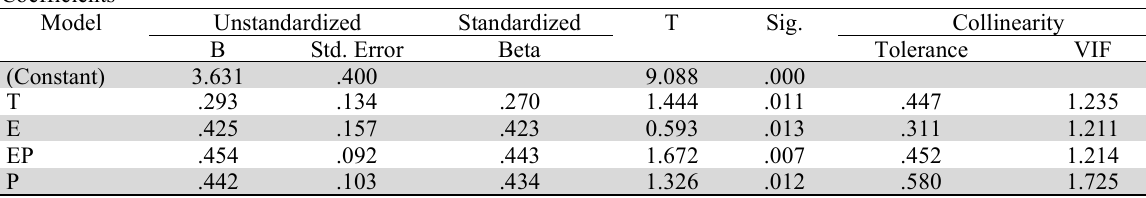
Coefficients a Model Unstandardized